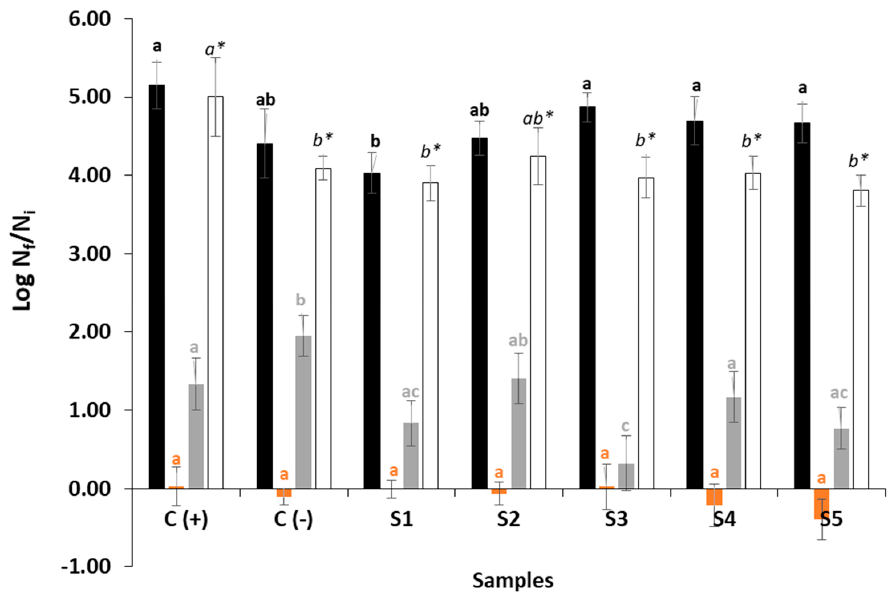
Figure 2. Microbial count increase during 14 days of refrigeration storage of salmon burgers. Total viable count of psychrotrophic microorganisms ( ■ , black letters), molds and yeasts ( ■ , orange letters), lactic acid bacteria (LAB) ( ■ , gray letters), coliforms ( □ , italic and asterisk *). See Table 1 for details of the antioxidant composition in burger samples. Different letters mean significant differences between groups of microorganisms (mean ± SD).